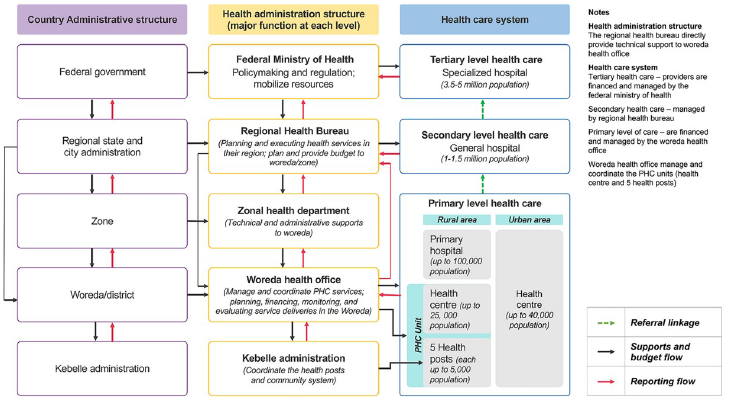
Fig 1. Ethiopian health care system. Source [9, 11,